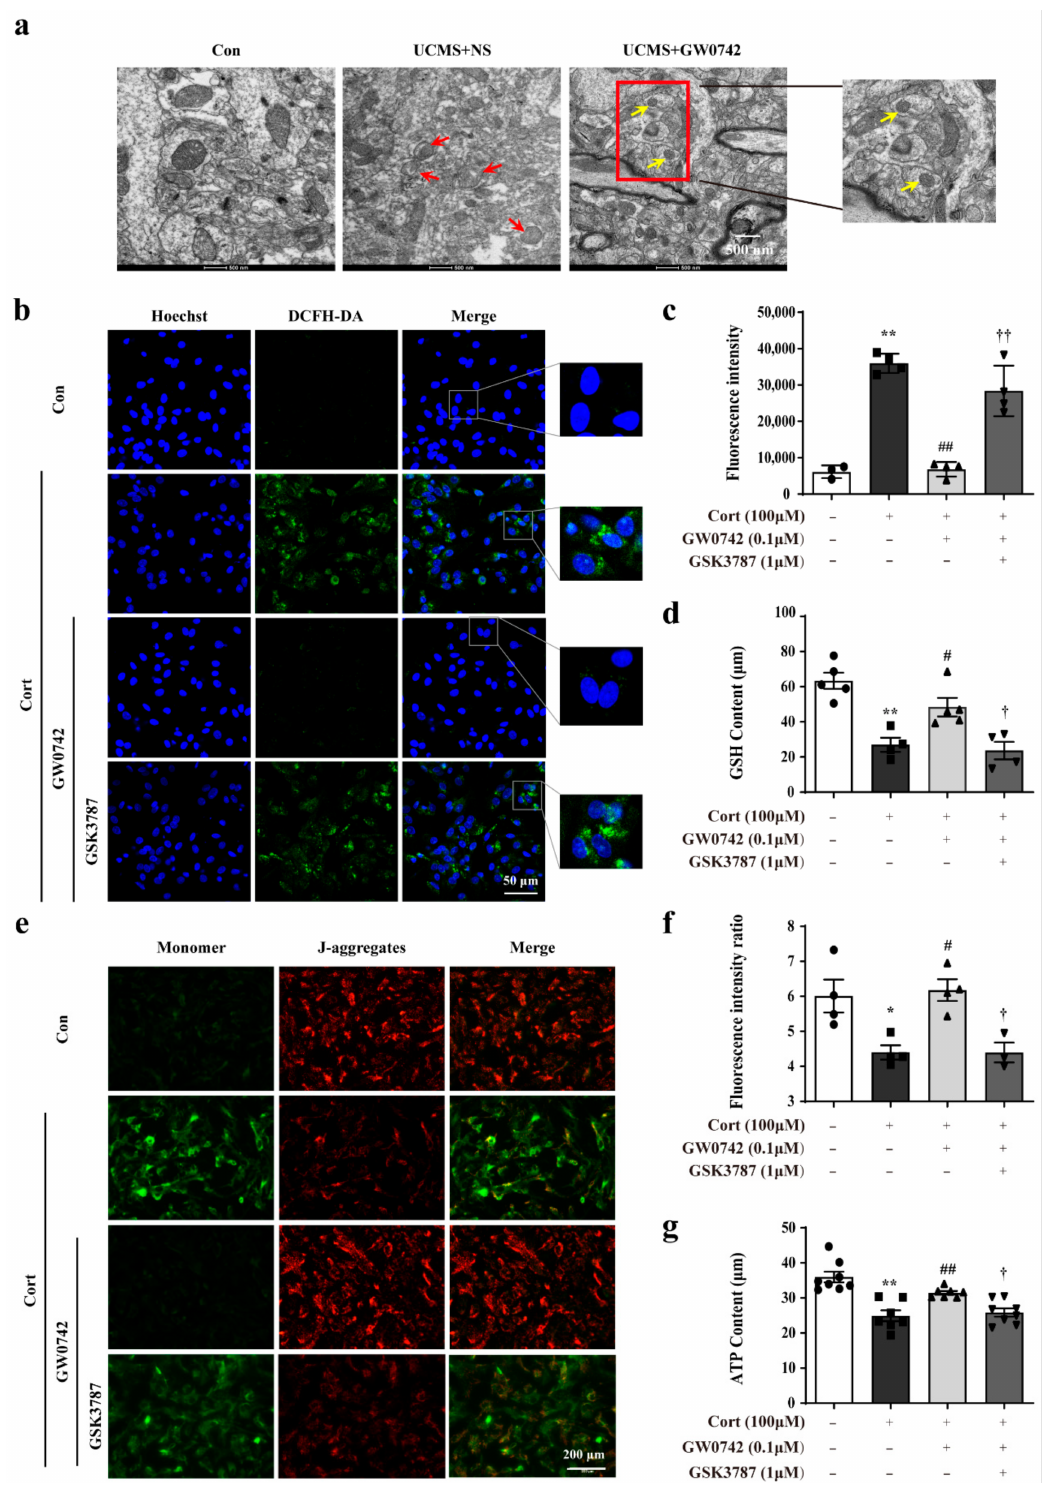
Figure 3. GW0742 ameliorates oxidative stress-induced damages in astrocytes. Representative TEM images are used to observe the structure of mitochondria ( a ) in hippocampal astrocytes. Scale bar = 2 µ m and 500 nm. The structure of damaged mitochondria is shown as the red arrows. The formation of autophagosomes is shown as yellow arrows. After staining astrocytes with DCFH-DA probe, the fluorescence intensity of ROS was captured under fluorescence microscope ( b ) and the